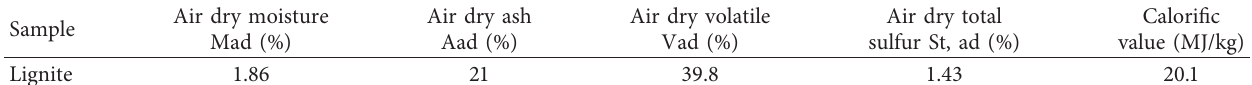
Table 1: Coal quality indicators of lignite specimen.